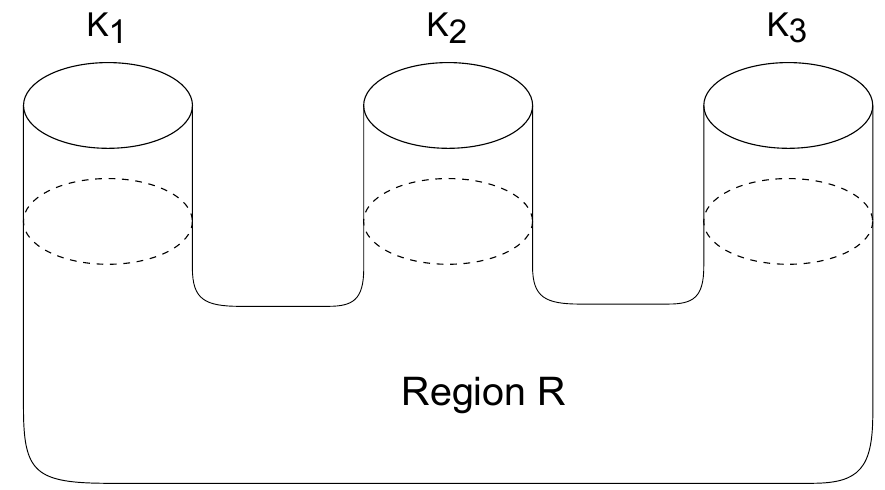
Figure 7 . Multiple